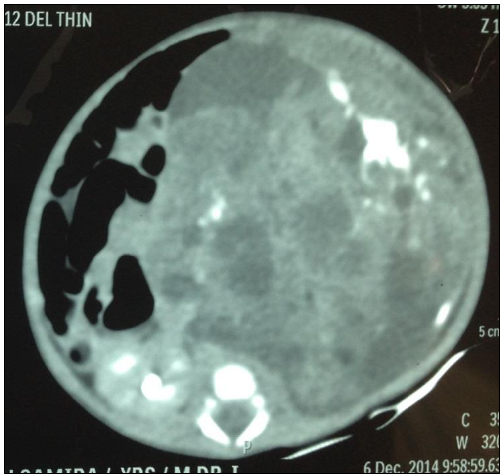
Figure 1: CT scan of the abdomen showing solid cystic tumor in retroperitoneum with foci of